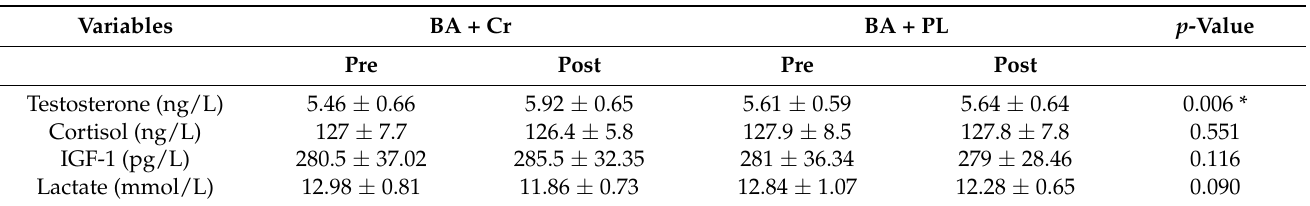
Table 3. Resting hormonal levels and post-exercise blood lactate before and after 4 weeks of supple-